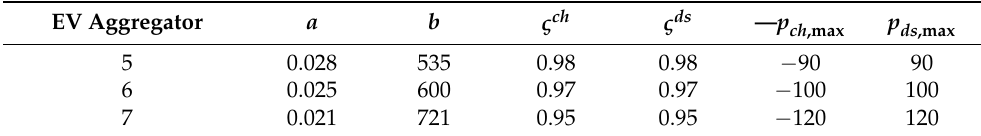
Table 2. Generator operating cost function parameters and output upper and lower limits.